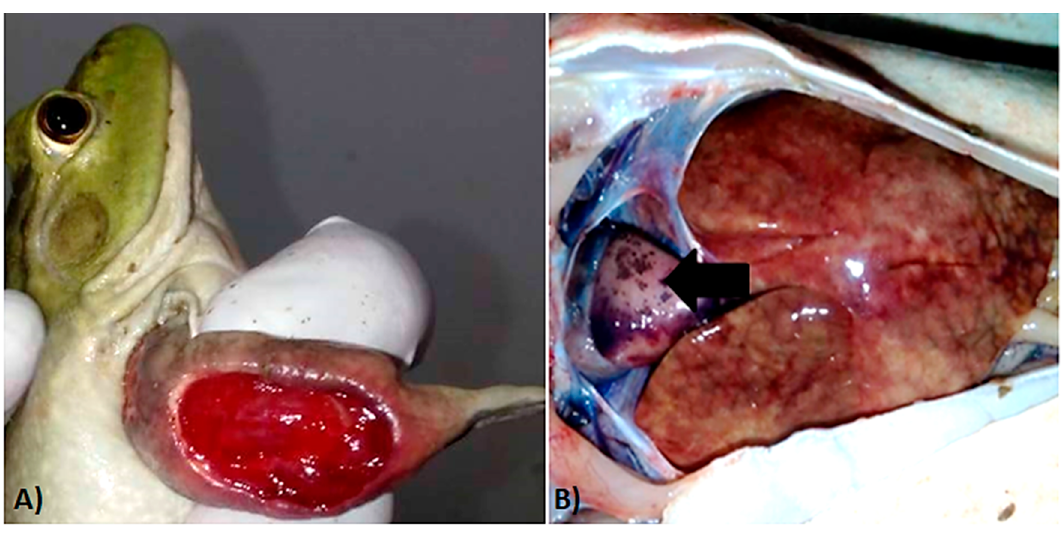
Figure 3. Histopathology of ranavirus-infected American bullfrogs. ( A ) Liver section from an affected bullfrog with mild congestion of sinusoids. ( B ) Kidney section shows an area of mild tubular necrosis characterized by cytoplasmic hyper-eosinophilia, loss of nuclei, and mild nuclear pyknosis (black square). Intraluminal protein casts are also seen (black arrows). Hematoxylin/Eosin staining. Magnification for all photos 20×/100 µm.